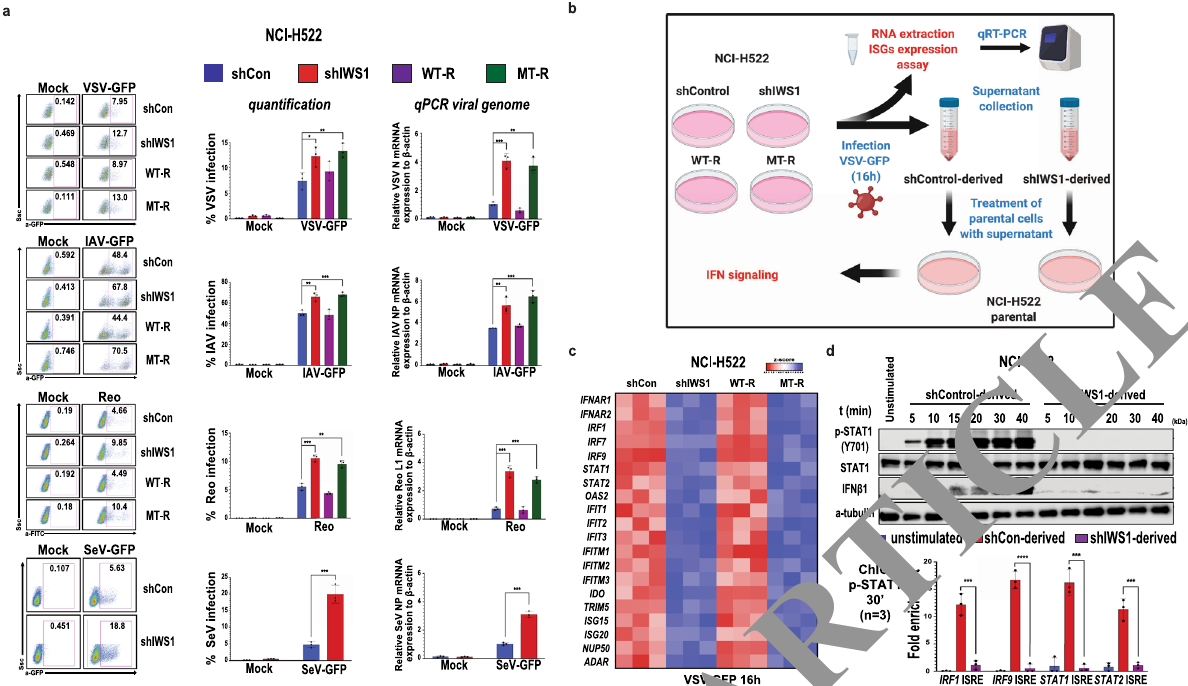
Fig. 6 The low expression of type I IFNs in shIWS1 and shIWS1/MT-R cells enhances their sensitivity to viral infection. a Loss of IWS1 expression and phosphorylation, enhance the sensitivity of cells to viral infection . shControl, shIWS1, shIWS1/WT-R and shIWS1/MT-R NCI-H522 cells were infected with VSV-GFP, In fl uenza A-GFP (IAV-GFP) or Reovirus. In addition, shControl and shIWS1 NCI-H522 cells were infected with SeV-GFP. All infections and analyses were carried out as described in the methods. (Left panels) Flow-cytometric analyses, representative of three independent experiments. (Middle panels) Quanti fi cation of the data from all three experiments. Bars show the percentage of infected cells ±SD. (Right panels) The expression of viral genes in cells infected with the same viruses was quanti fi ed by qRT-PCR, as described in the methods. Bars show the relative expression of viral genes ±SD. b Design of the experiment in c and d . The indicated cells were infected with VSV-GFP (MOI = 0.5). 16 h later, total RNA was harvested and analyzed by qRT- PCR for the expression of the mRNAs of 20 ISGs. In parallel, the supernatants of shControl and shIWS1 cultures were harvested and used in a bioassay for the abundance of biologically active IFN-type-I. Naïve NCI-H522 cells were treated with the supernatants and examined for STAT1-phosphorylation and the binding of phosphor-STAT1 to the ISREs of four ISGs. The schematic was created with Biorender.com under the third-party publication license permission UR22MWA47E. c Heatmaps showing the relative expression of 20 ISGs in the indicated cells, as determined by qRT-PCR. ISG expression was normalized to 18 S rRNA. Heatmaps were based on z scores, derived from experiments on three biological replicates, done in triplicate. d (Upper panel). Naïve NCI- H522 cells were treated with culture supernatants as described in 6b. Cell lysates were harvested at the indicated time points and probed with the indicated antibodies. (Lower panel) The cells in the upper panel were harvested at 30 ’ from the start of the exposure to the supernatants, and the lysates, were used to carry out ChIC assays for p-STAT1 binding. The bars show the mean fold enrichment in p-STAT1 binding to the ISREs of four ISGs±SD, (anti- p-STAT1 IP vs IgG-IP). All assays were done on three biological replicates. * p < 0.05, ** p < 0.01, *** p < 0.001, **** p < 0.0001 (one-side unpaired